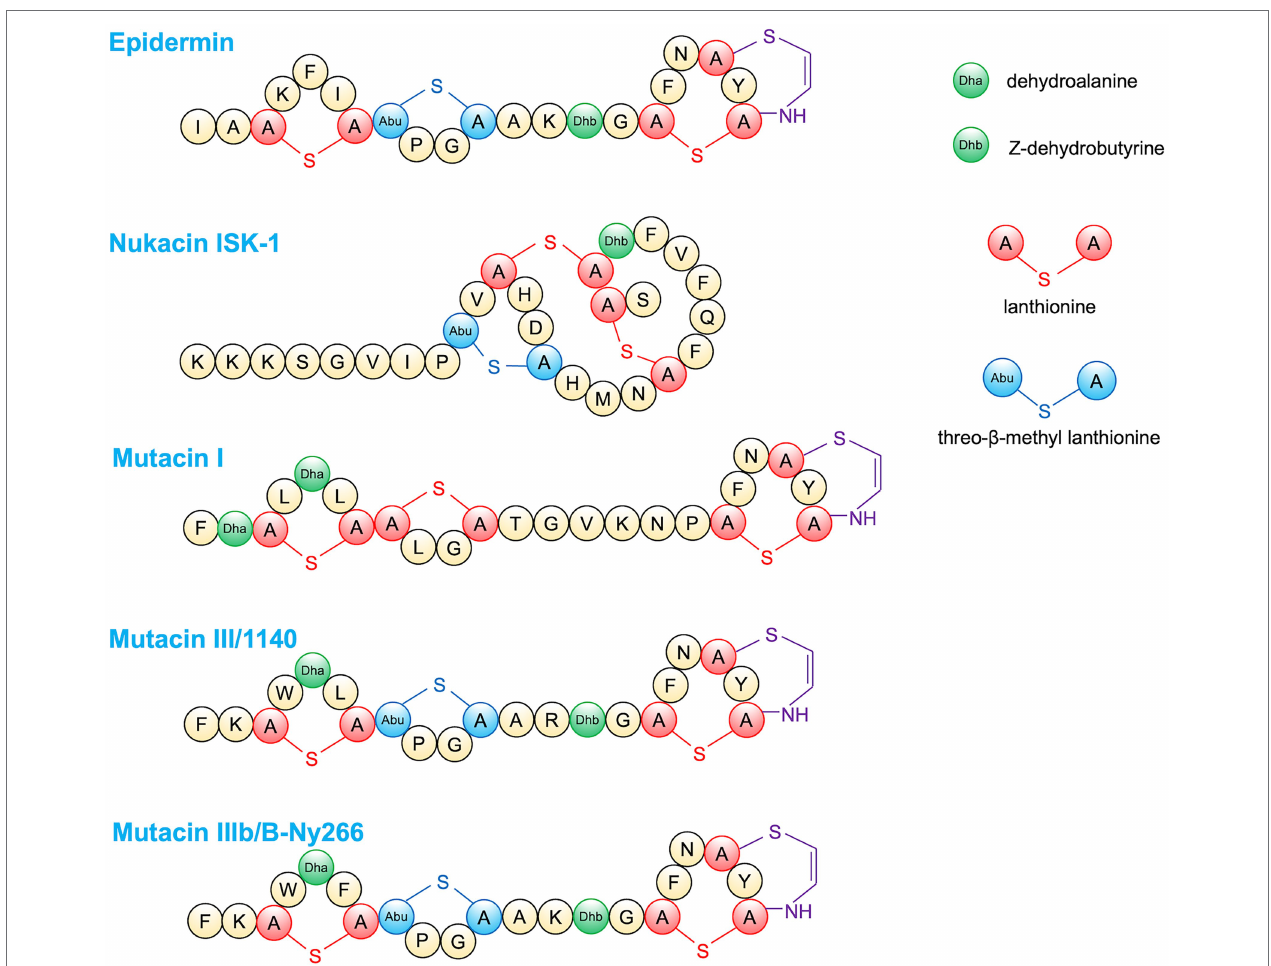
FIGURE 4 | Amino acid structures of lantibiotic